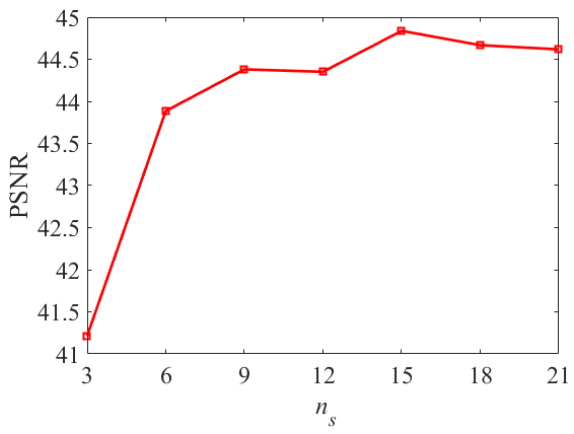
Figure 8. PSNR values for different n s